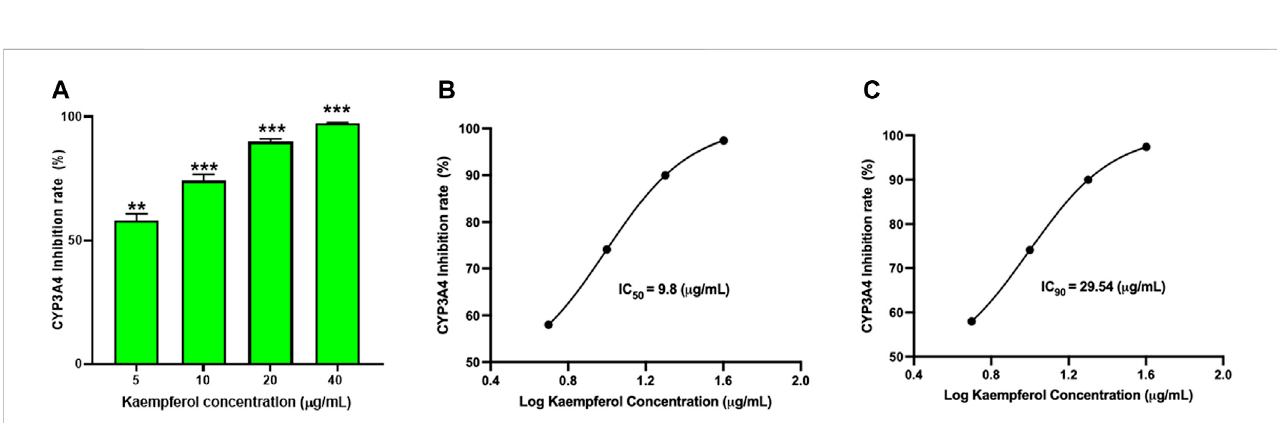
FIGURE 7 Kaempferol dose dependent inhibition of CYP3A4 activity: The inhibition of CYP3A4 was measured by commercially available Vivid assay kit as per manufacturers instruction. (A) Kaempferolshowed dose-dependentsuppression ofCYP3A4 enzyme activity. The IC 50 and IC 90 werecalculated to be9.8 pg/ mL and 29.54 pg/mL respectively (B,C) . Data represents triplicate experiments and expressed as mean ± SD. " p < 0.01; *** p < 0.001 vs . control.